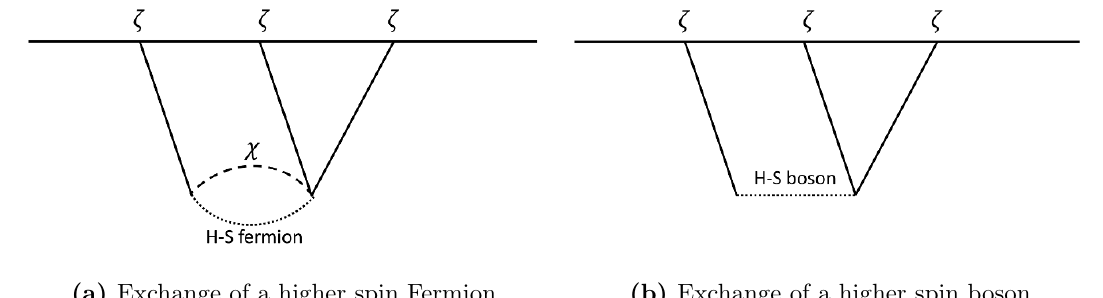
Figure 1. In-In formalism Feynman Diagrams for exchange of a single higher spin